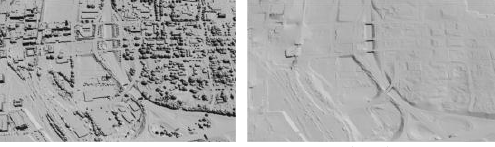
Figure 6. High-resolution DSM (left) and DTM (right) processed using automated dense matching with UltraCam images and UltraMap processing